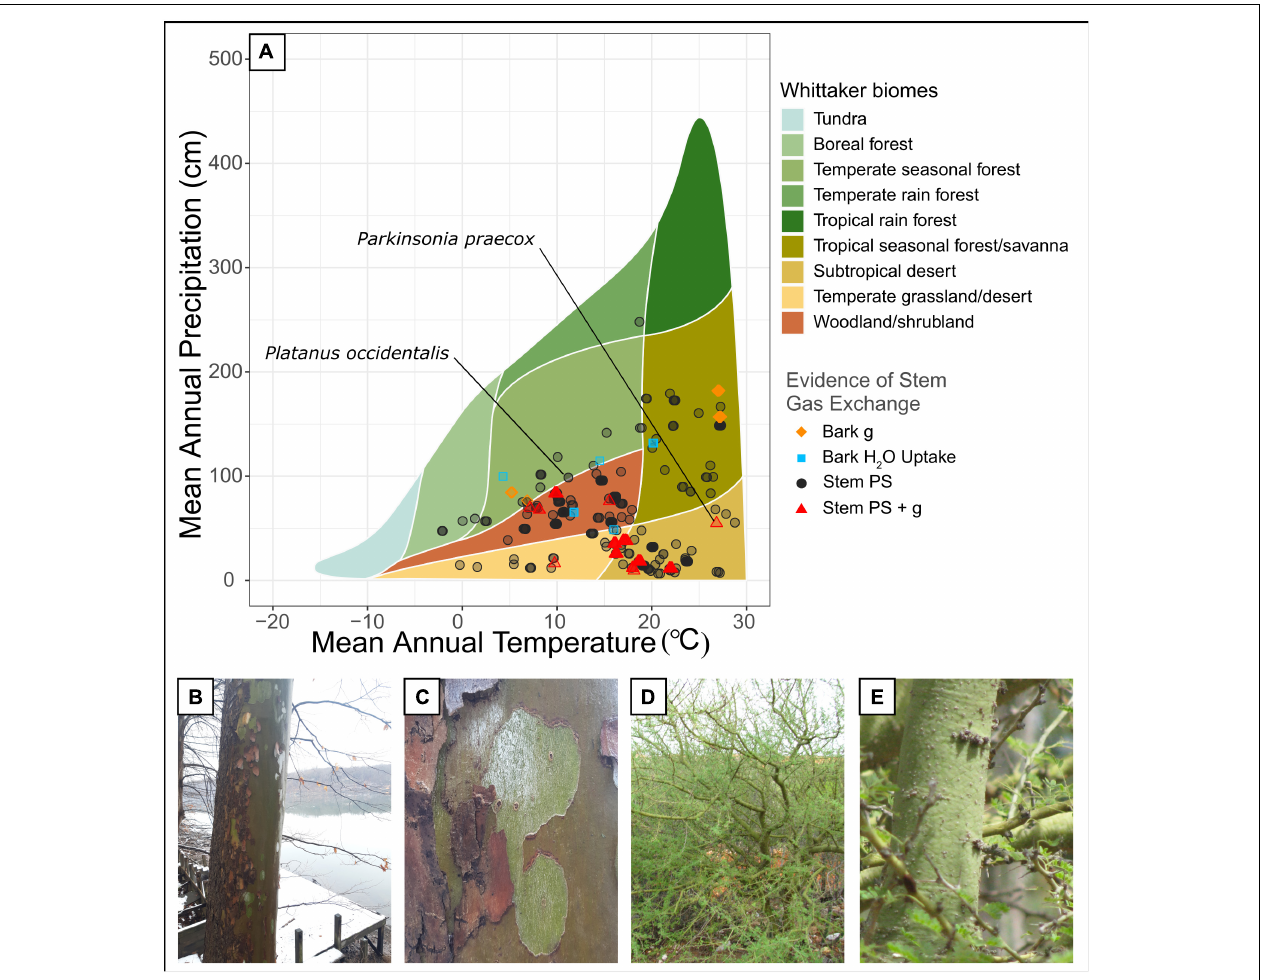
FIGURE 1 | (A) Whittaker plot showing the biomes where stem carbon dioxide and water exchange have been quantified (data come from Supplementary Table 1 ). Shown are observations where only bark photosynthesis was observed (including both net CO 2 uptake and CO 2 reassimilation, “Stem PS”), bark photosynthesis and bark conductance were both observed (“Stem PS + g”), only bark conductance was observed (“Bark g”), and bark water uptake was observed (“Bark H 2 O Uptake”). Observations were plotted as semi-transparent points in order to improve clarity of clustered points. (B,C) Sycamore tree ( Platanus occidentalis ) with green, deciduous bark, photographed at Cheat Lake, West Virginia (photos by N. Emery). (D,E) Foothill Palo Verde ( Parkinsonia praecox ) with bright green bark, photographed in a xerophytic woodland in Venezuela (photos by W.